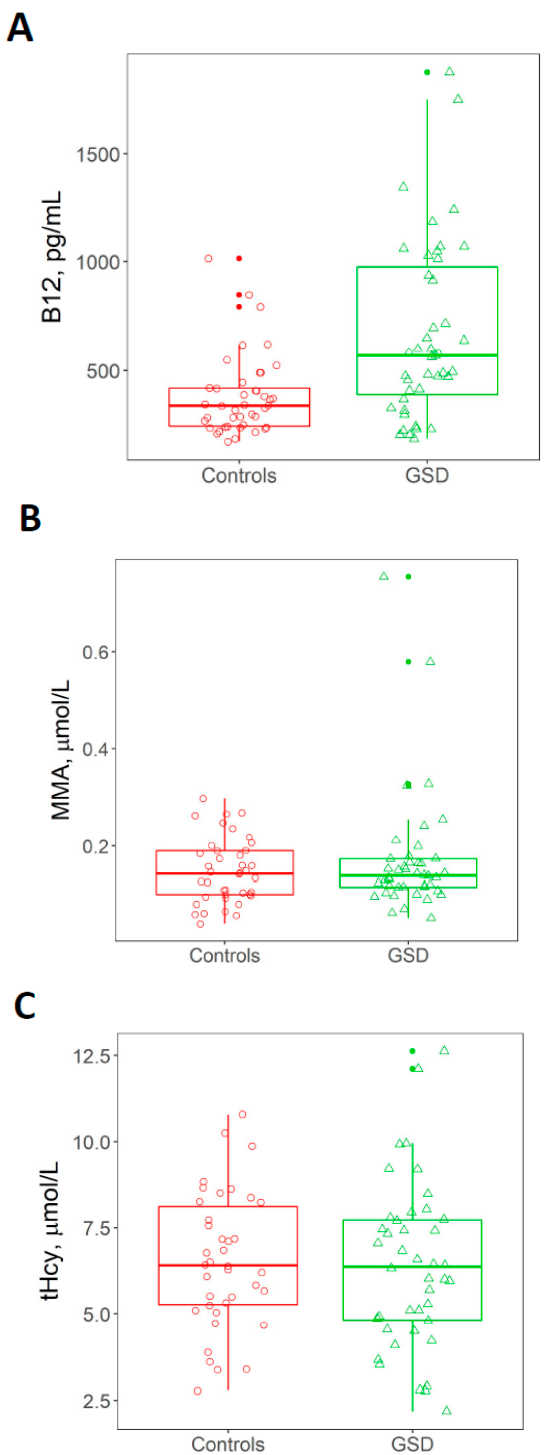
Figure 2. Biomarkers of vitamin B 12 status in healthy controls and GSD patients. Panel ( A ) Plasma vitamin B 12 ; Panel ( B ) Plasma MMA; Panel (C) Plasma tHcy. Median vitamin B 12 concentrations were significantly higher in GSD patients compared to healthy controls (*, p = 0.0002), whereas no statistically significant differences were found for homocysteine and MMA between the control and GSD patients. The middle line represents the 50th quartile (median). The lower and upper hinges represent the 25th and 75th quartiles, respectively. The distance between the 25th and the 75th quartiles depicts the inter ‐ quartile range (IQR). The upper whisker represents the largest value that extends no further than 1.5 times the IQR. The lower whisker represents the smallest value that extends up to 1.5 times the